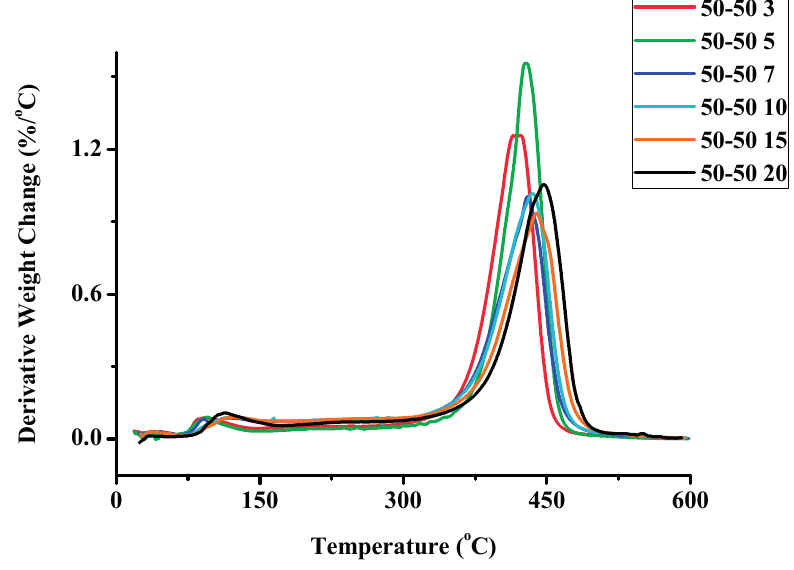
Figure 2. Derivative weight loss with temperature for the sample 50/50 under different heating rates.